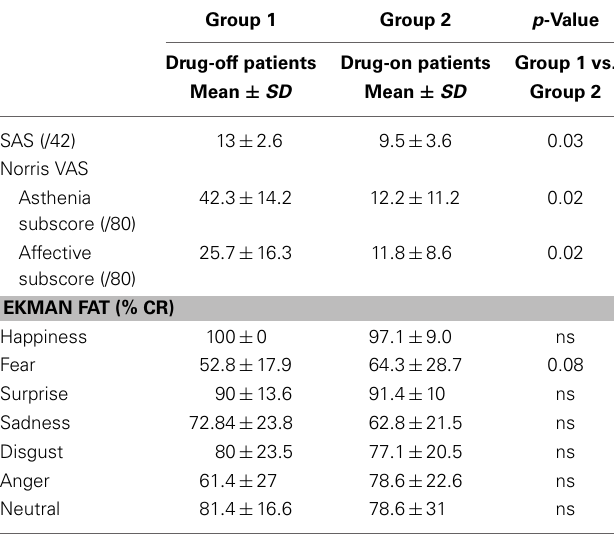
Table 2 | Neuropsychological characteristics of patients during the levodopa-challenge.